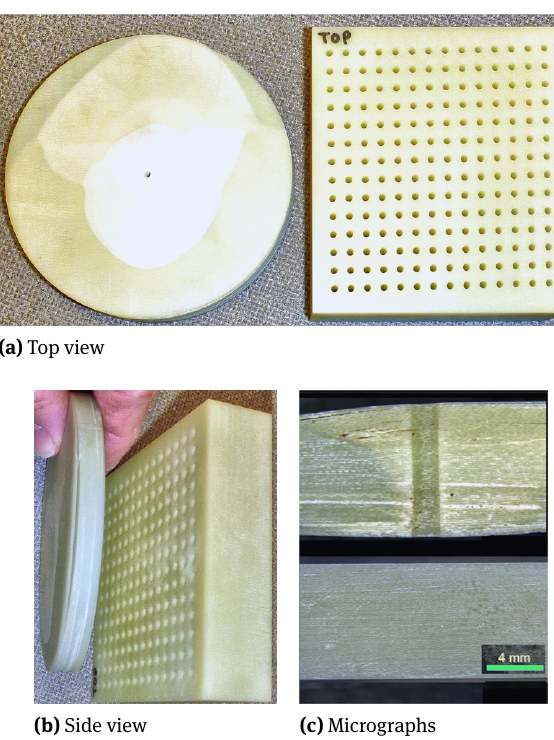
Figure 14: AWJ-drilled holes on G10 composite without and with Turbo Piercing.